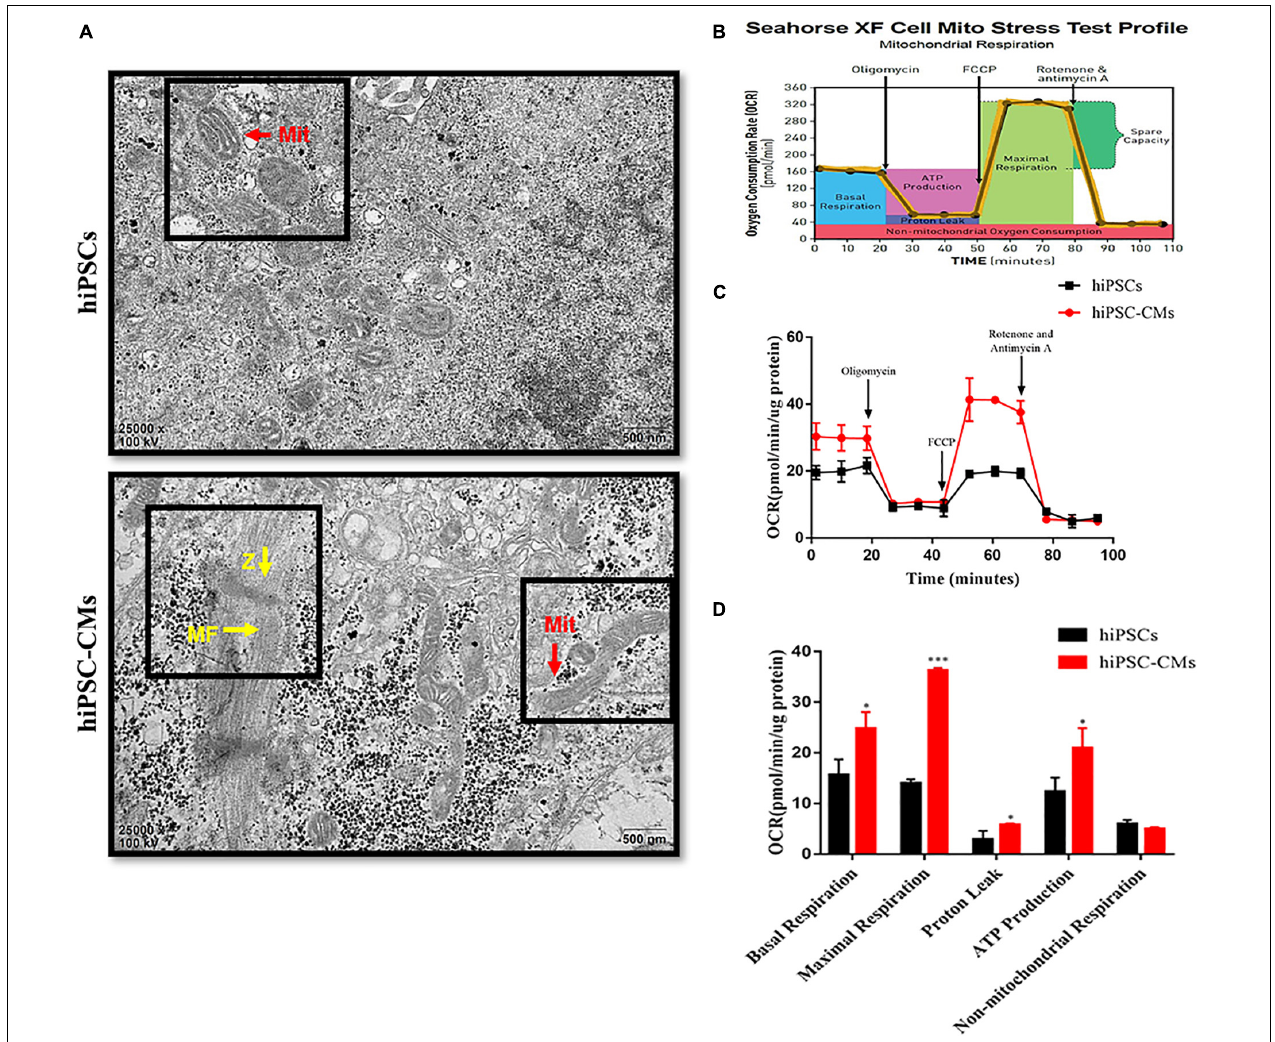
FIGURE 1 | Changes in mitochondrial morphology and respiratory function after differentiation of hiPSCs into hiPSC-derived CMs. (A) Transmission electron microscopy images of hiPSCs and hiPSC-CMs illustrating the differences in mitochondrial morphology. Scale bar = 500 nm. hiPSC-CMs showed more mature, elongated, and large mitochondria with denser intramitochondrial cristae compared to those in hiPSCs. hiPSC-CMs had visible Z-bands and regular arrangement of myofibrils. Z, Z-bands, yellow arrows; MF, myofibrils; yellow arrows; Mit, mitochondria, red arrows. (B) Scheme of the mitochondrial stress test in the cells. (C) Two representative OCR traces of hiPSCs and hiPSC-CMs in response to oligomycin, FCCP, rotenone, and antimycin A ( n = 12). (D) Statistical analysis of the differences in basal respiration, maximal respiration, proton leakage, ATP production, and non-mitochondrial respiration ( n = 12). * P < 0.05, *** P < 0.001, compared with hiPSCs, unpaired t